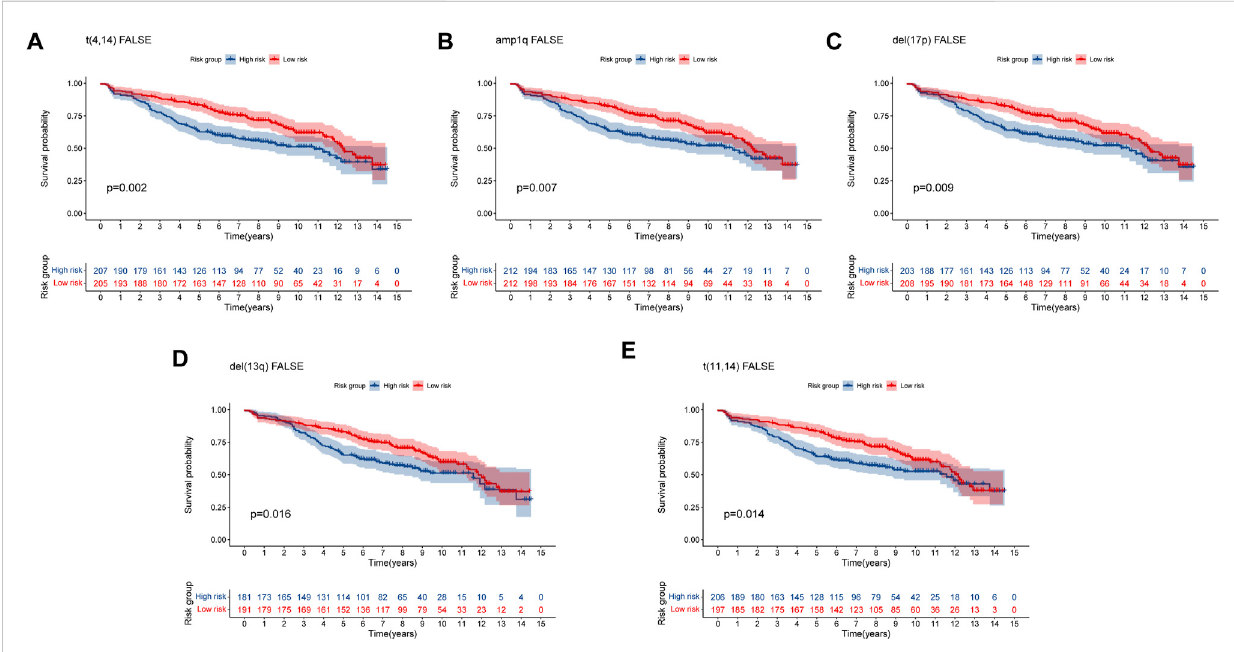
FIGURE 8 Validationoftheeight-generiskscoremodelinpatientswithoutgeneticindicatorsbyKaplan – Meiercurves. (A) MMpatientswithoutt(Palumboand Anderson, 2011; Lipchick et al., 2016) ( p = 0.002). (B) MM patients without amp1q ( p = 0.007). (C) MM patients without del (17p) ( p = 0.009). (D) MM patients without del (13q) ( p = 0.016) (E) MM patients without t (Schieber and Chandel, 2014; Lipchick et al., 2016) ( p = 0.014). MM patients were divided into high-risk and low-risk groups by the median risk